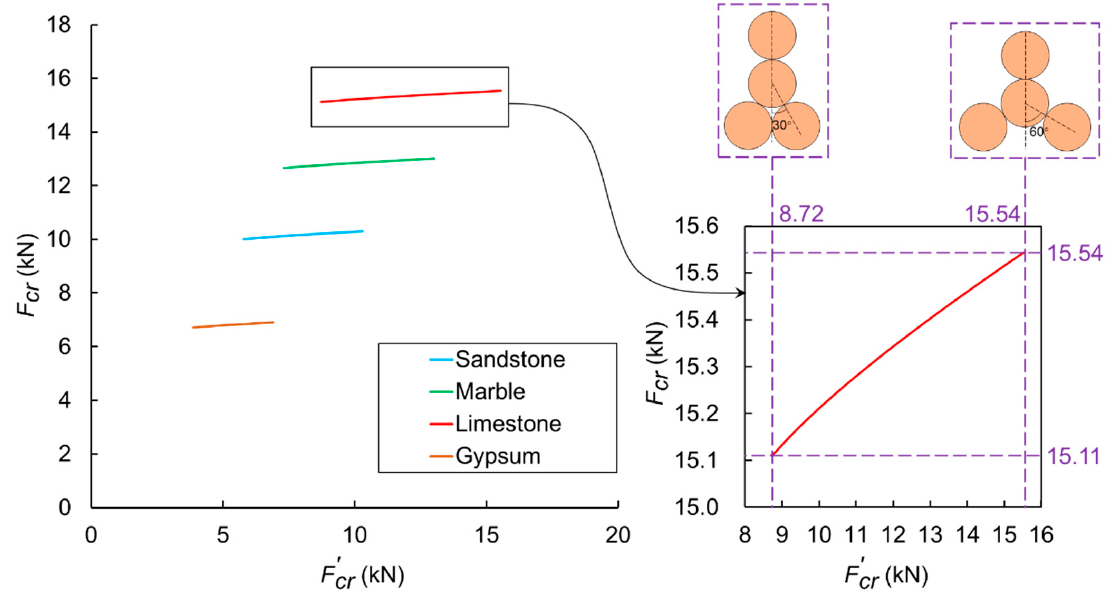
Figure 6. The relationship between F cr and F cr’ for different materials. The mechanical parameters of the materials were obtained by Zhou [45].